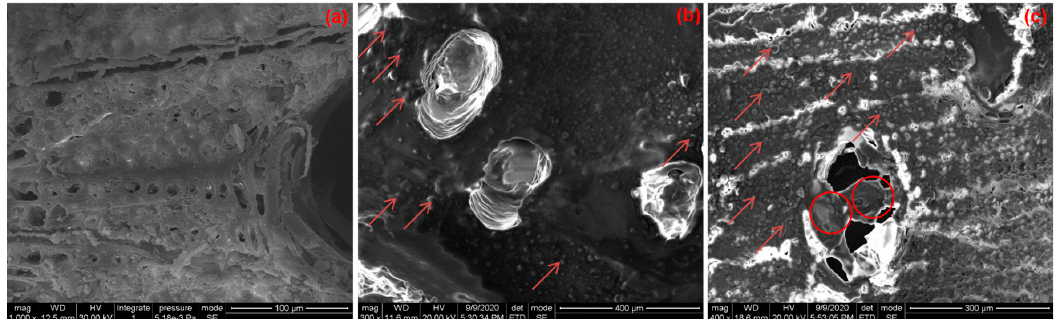
Figure 4. SEM observations of the control samples ( a ), wax impregnated samples ( b ), and cutting slices ( c ). Red arrows indicate wax with shaped droplets, and red circles show the layers of wax formed.